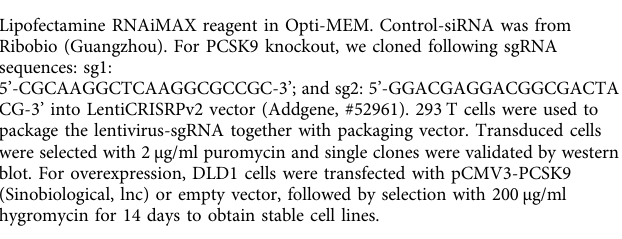
Fig. 5 PCSK9 promotes APC / KRAS -mutant CRC growth in vivo and growth inhibitory effect of PCSK9 inhibitors. A PCSK9 knockout suppressed growth of subcutaneous xenograft model of SW1116 cells in NOD/SCID mice ( n = 1 experiment, n = 9 mice per group). B PCSK9 knockout inhibited cell growth as indicated by Ki-67 staining ( n = 5); TUNEL showed that PCSK9 knockout induced apoptosis in SW1116 xenografts ( n = 5). C PCSK9 overexpression in DLD1 cells induced xenograft growth in nude mice ( n = 1 experiment, n = 10 mice per group). D PCSK9 overexpression in DLD1 cells induced cell growth and inhibited apoptosis, as evidenced by Ki-67 ( n = 7) and TUNEL ( n = 8) assays, respectively. E Western blot of SW1116 xenografts revealed that PCSK9 knockout suppressed p-ERK, Cyclin D1, and CDK4. Western blot of DLD1 xenografts demonstrated increased expression of p-ERK, Cyclin D1, and CDK4. F GGPP levels in SW116 xenografts with PCSK9 knockout ( n = 8) and DLD1 xenografts with PCSK9 overexpression ( n = 10). G Effect of Evolocumab on 1CT, 1CT-AK, and DLD1 cells ( n = 3). H Effect of R-IMPP and PF-0644846 on 1CT, 1CT-AK, and DLD1 cells ( n = 3). 72 h-IC 50 values of R-IMPP and PF- 0644846 in a panel of APC / KRAS mutant CRC, 1CT isogenic cells and NCM460 cells. I Effect of Evolocumab, R-IMPP, and PF-0644846 on cell viability of primary organoids from human APC / KRAS -mutant CRC after 5 – 7 days of treatment ( n = 4). J Effect of Evolocumab, R-IMPP and PF-0644846